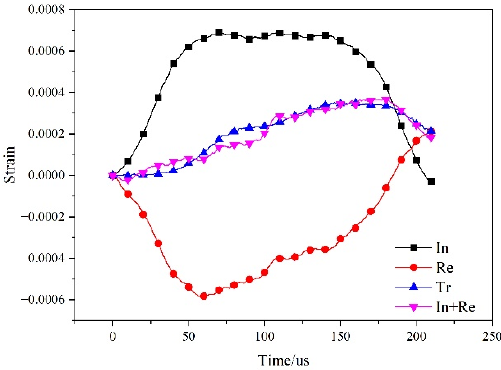
Figure 7. Verification of dynamic force balance of the sandstone.